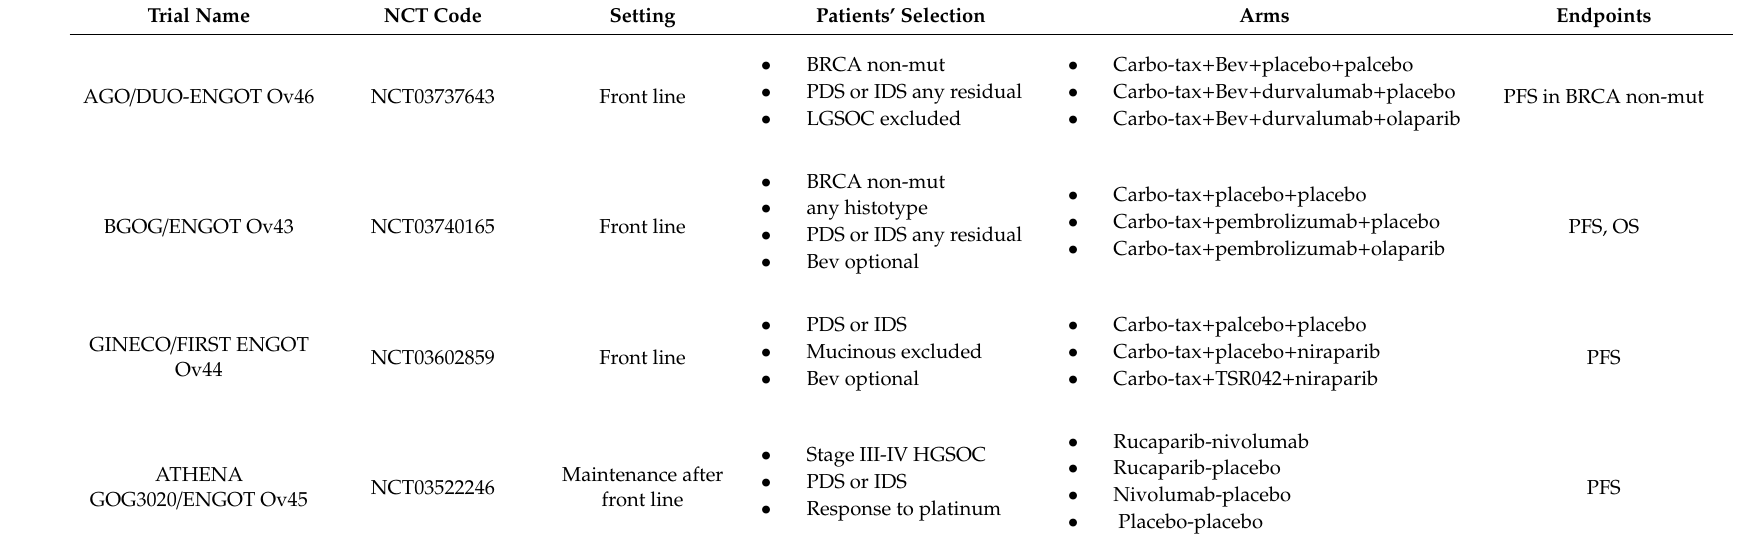
Table 2. Ongoing phase III clinical trials exploring combination of CPIs and poly (ADP-ribose) polymerase (PARP) inhibitors